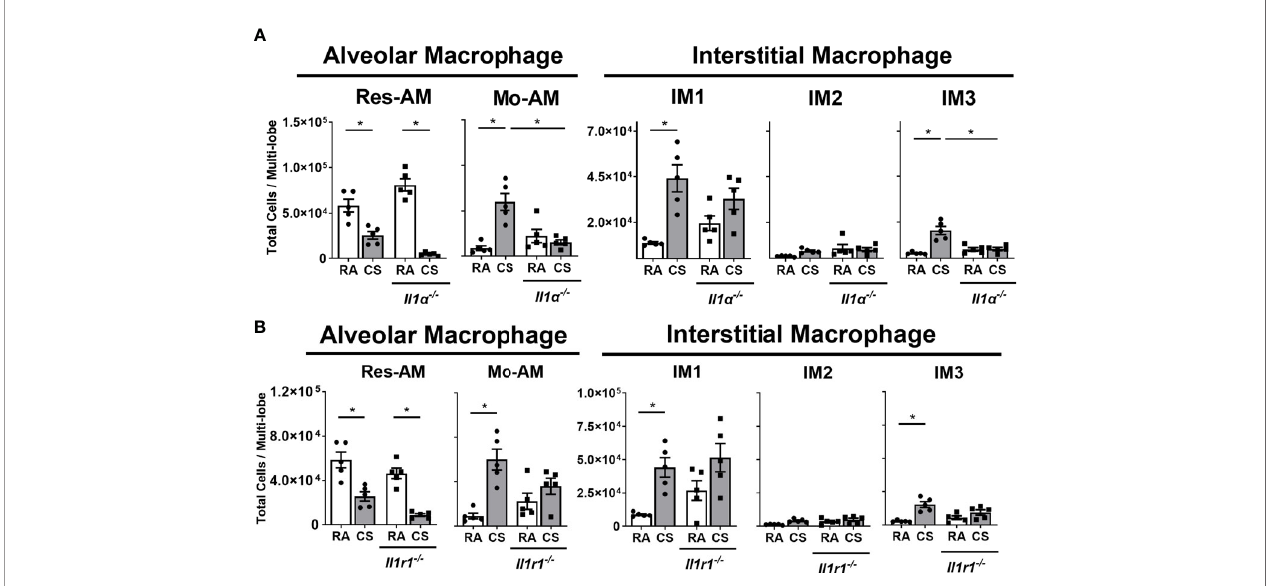
FIGURE 4 | Macrophage expansion in cigarette smoke-exposed lung is IL-1 a dependent. Data show total lung Res-AM, Mo-AM, IM1, -2 and -3 populations in (A) Il1a -/- and (B) Il1r1 -/- mice compared to C57BL6 wild type control mice at 8-weeks CS. Data show mean ± SEM, n = 5. Two-way ANOVA with Tukey ’ s multi- comparison test. RA, room air; CS, cigarette smoke. *p <